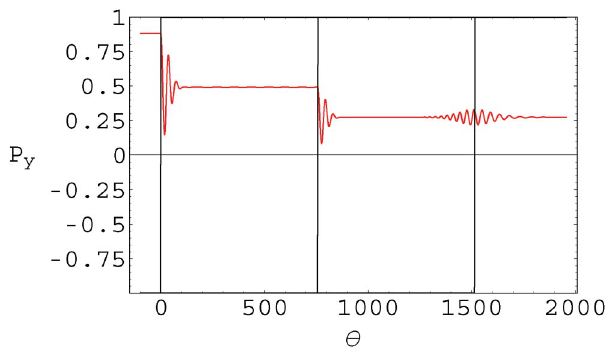
FIG. 3. (Color) An echo effect occurs long time after resonance crossings even when the beam energy spread is